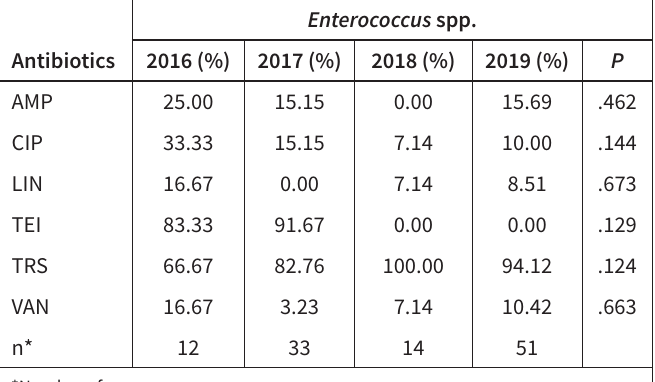
Table 5. Trends in Antibiotic Resistance Rates of Enterococcus spp. Enterococcus Antibiotics